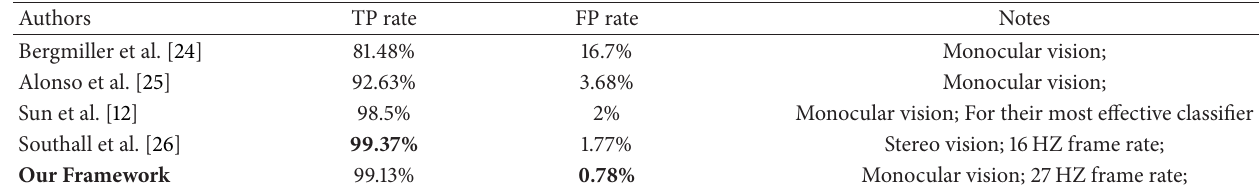
Table 2: Overall vehicle detection effects